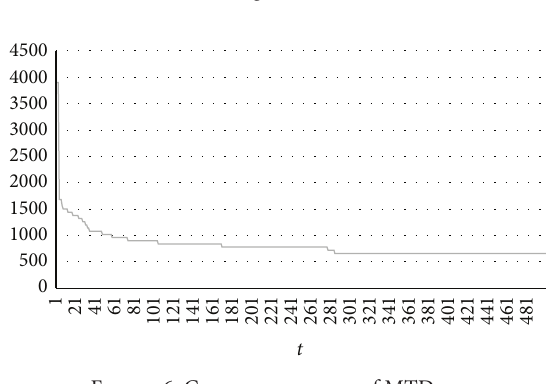
Figure 5: Convergence curve of ATD.